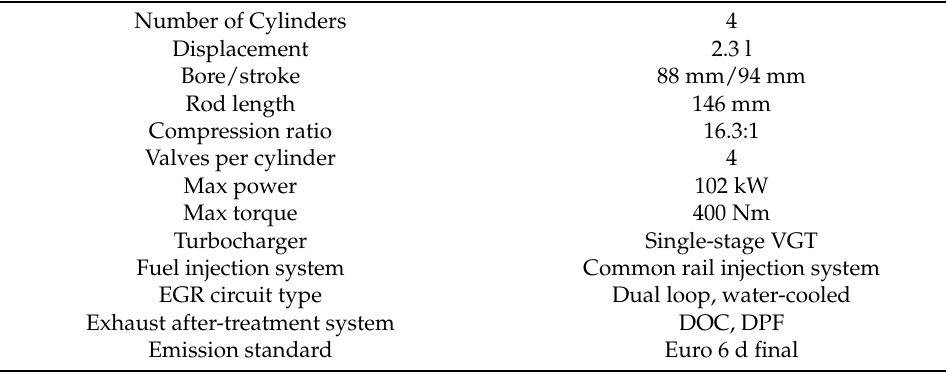
Table 1. Main technical specifications of the F1A Euro 6 engine. Number of